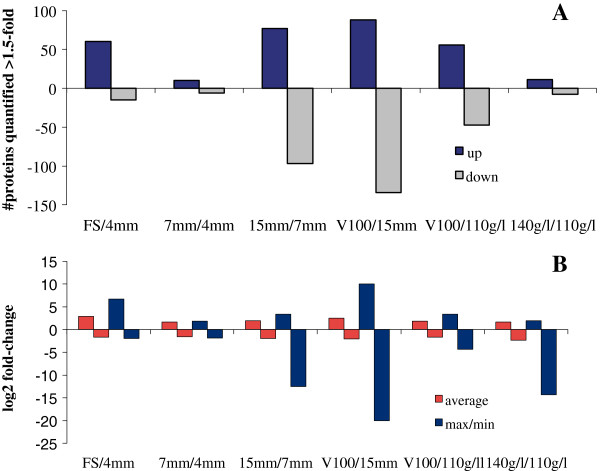
Overall changes in the protein level throughout berry development. Each value represents (A) the number of sequences quantified between two consecutive developmental stages, for all the proteins that were up- (dark blue bars) and down-regulated (gray bars), and (B) the fold-change of the proteins, represented as mean (red) and max/min (blue) changes. Transitions were: fruit set to 15 mm (FS-to-15 mm), 4 mm to 15 mm (4-to-15 mm), and 7 mm to 15 mm (7-to-15 mm), respectively. The experiment linked to the ripe stages was stated as follows: V100 to 15 mm (V100-to-15 mm), 110 g/l to 15 mm (110-to-15 mm) and 140 g/l to 15 mm (140-to-15 mm). An arbitrary fold change cutoff of ± 1.5 was used to select the protein subsets.